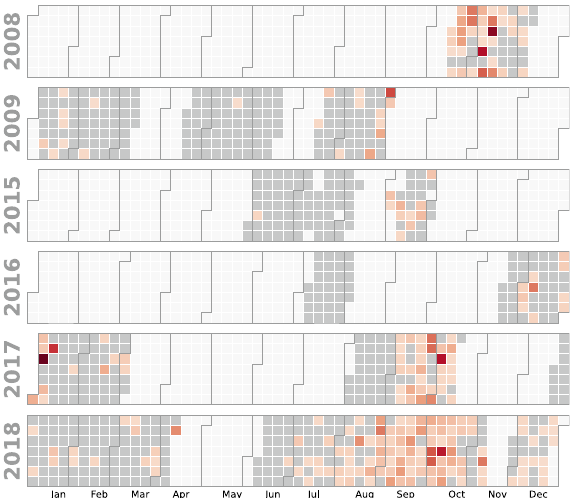
Figure 3. Calendar of the recorded days (grey cells). Shades of red denote the number of detected pulses normalized by the number of recorded hours (ranging from 0 to